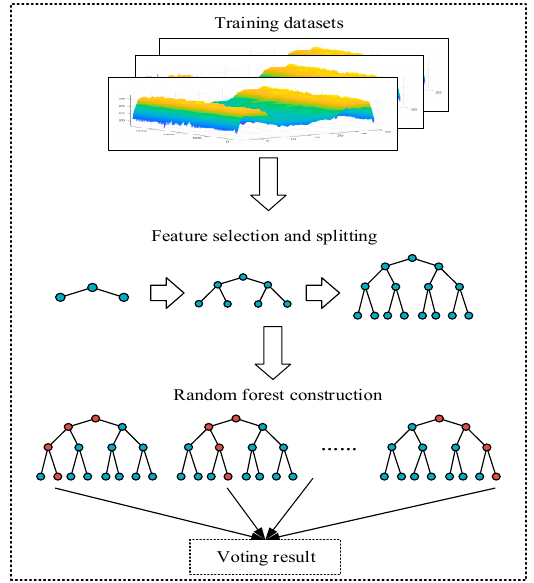
Figure 3. Random forest construction process.